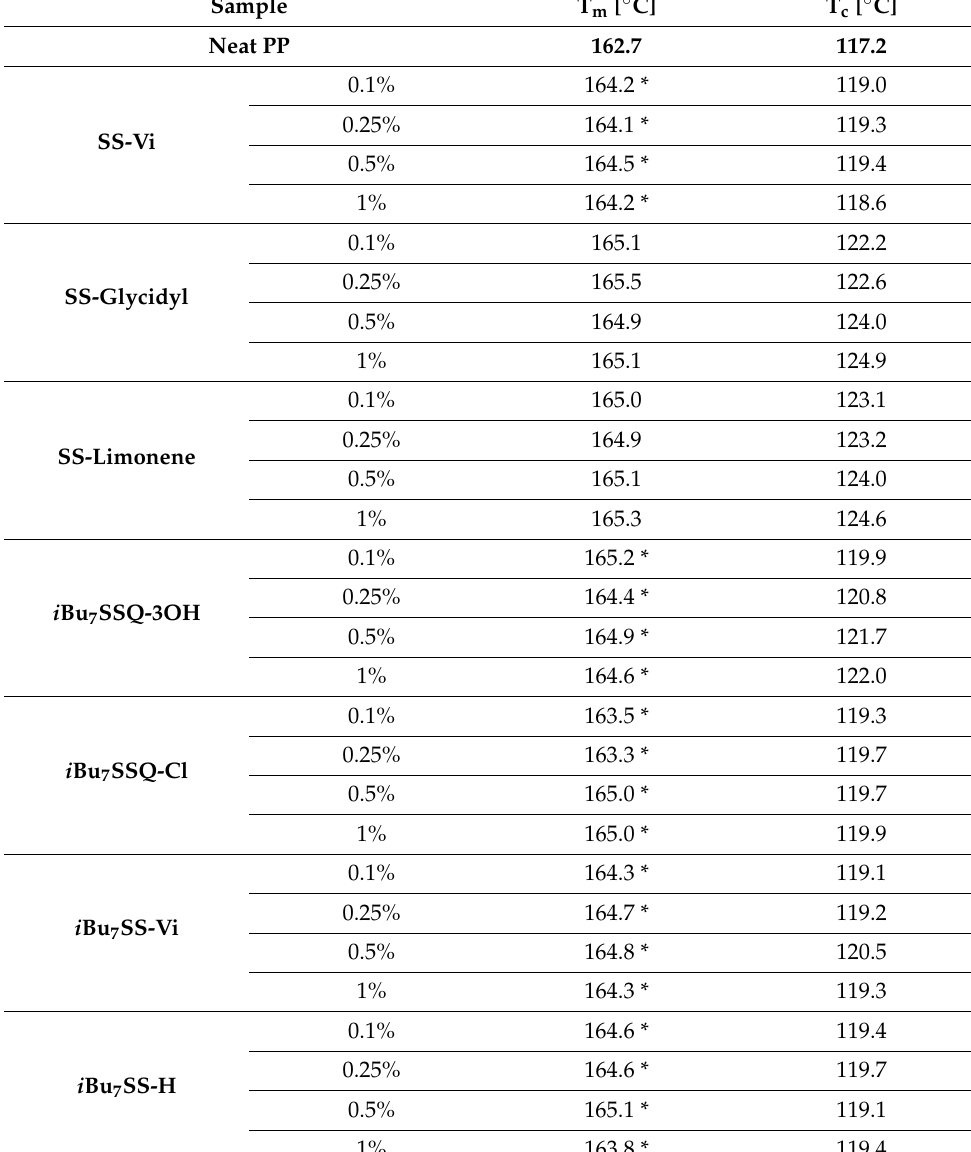
Table 2. Results of DSC analysis of CS/iPP